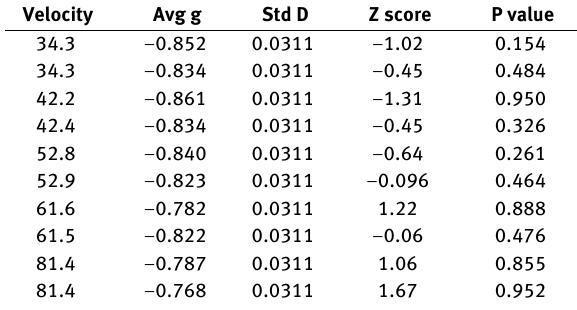
Table 4. Significance of variance in the average tyre/road friction coefficient in a vehicle without antilock braking